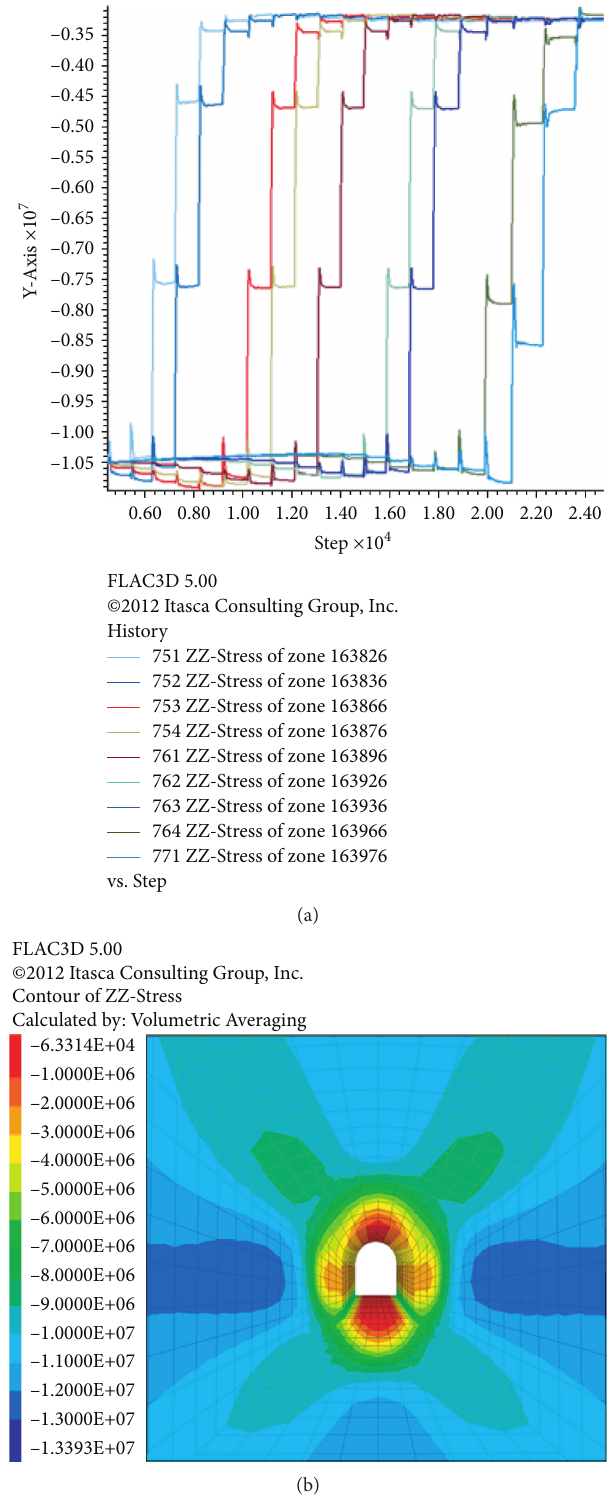
Figure 13: Vertical stress variation of tunnel roof: (a) Stress variation curve of tunnel roof, (b) Stress variation cloud map of tunnel